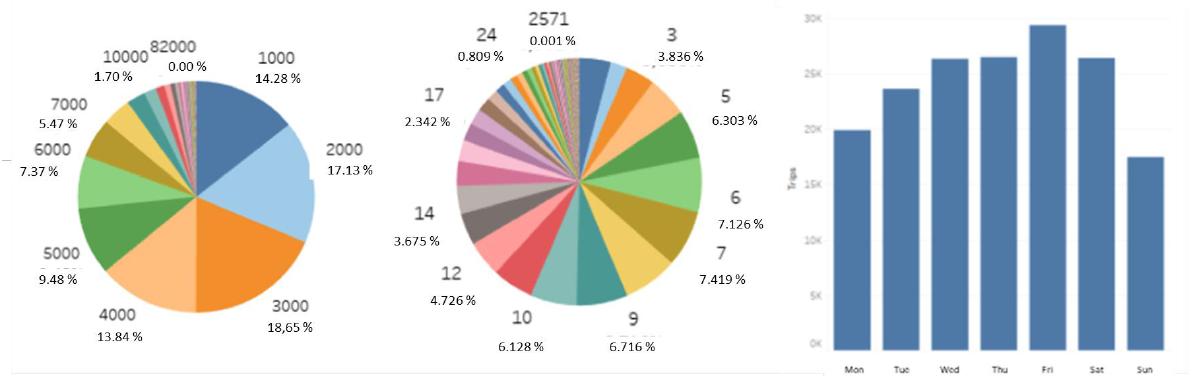
Figure 2: Driven distance in percent, Usage time in percent and Rentals per